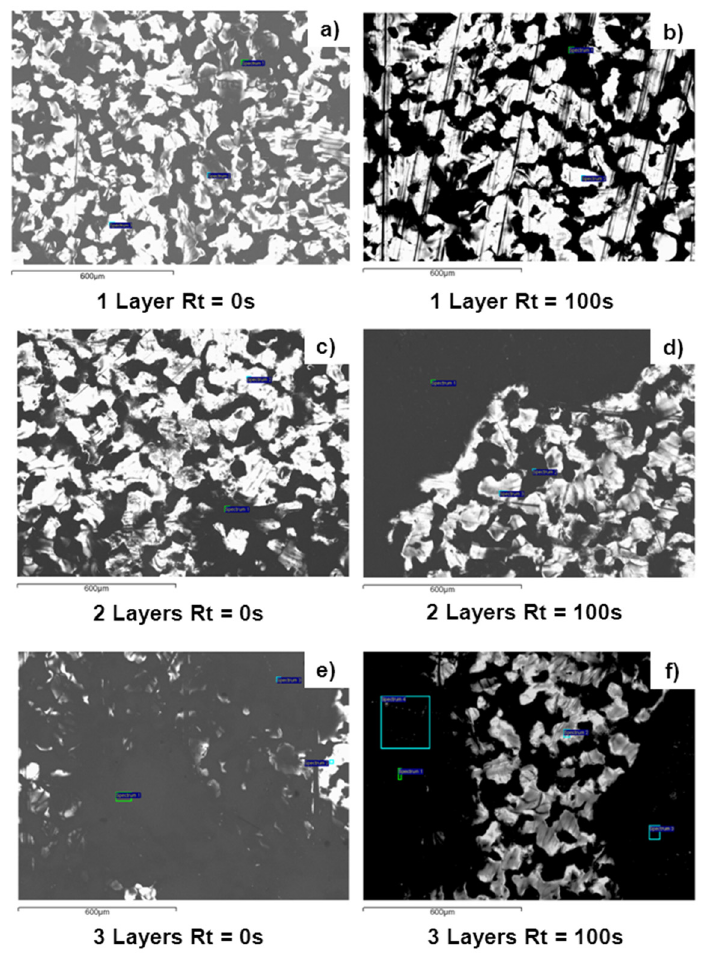
Figure 2. SEM images of HDGS sample coated with U(400): one layer ( a ) Rt = 0 s and ( b ) Rt = 100 s; two layers ( c ) Rt = 0 s and ( d ) Rt = 100 s; three layers ( e ) Rt = 0 s and ( f ) Rt = 100 s.